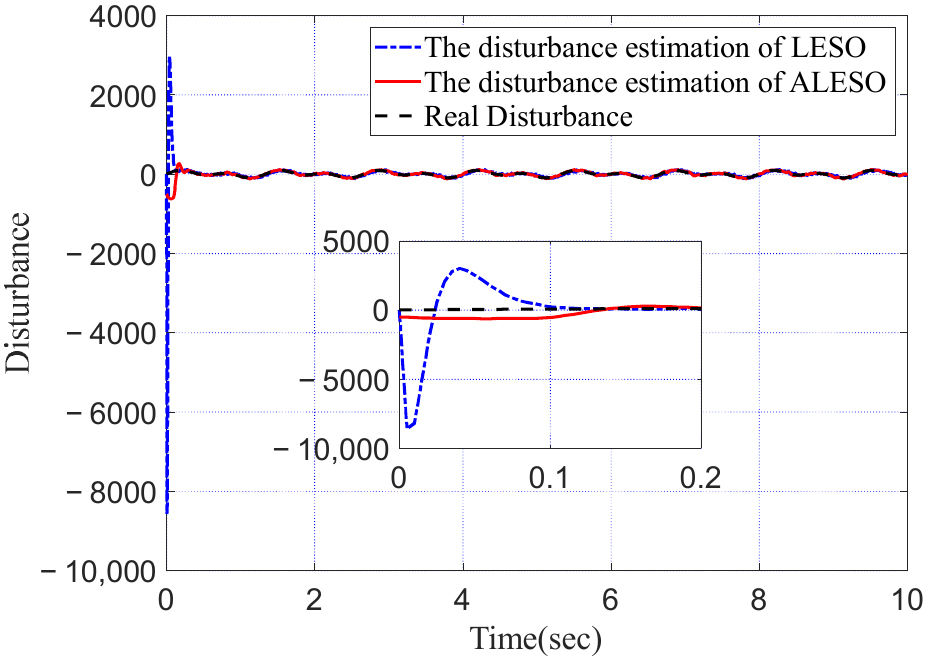
Figure 5. The disturbance estimations of LESO and ALESO.